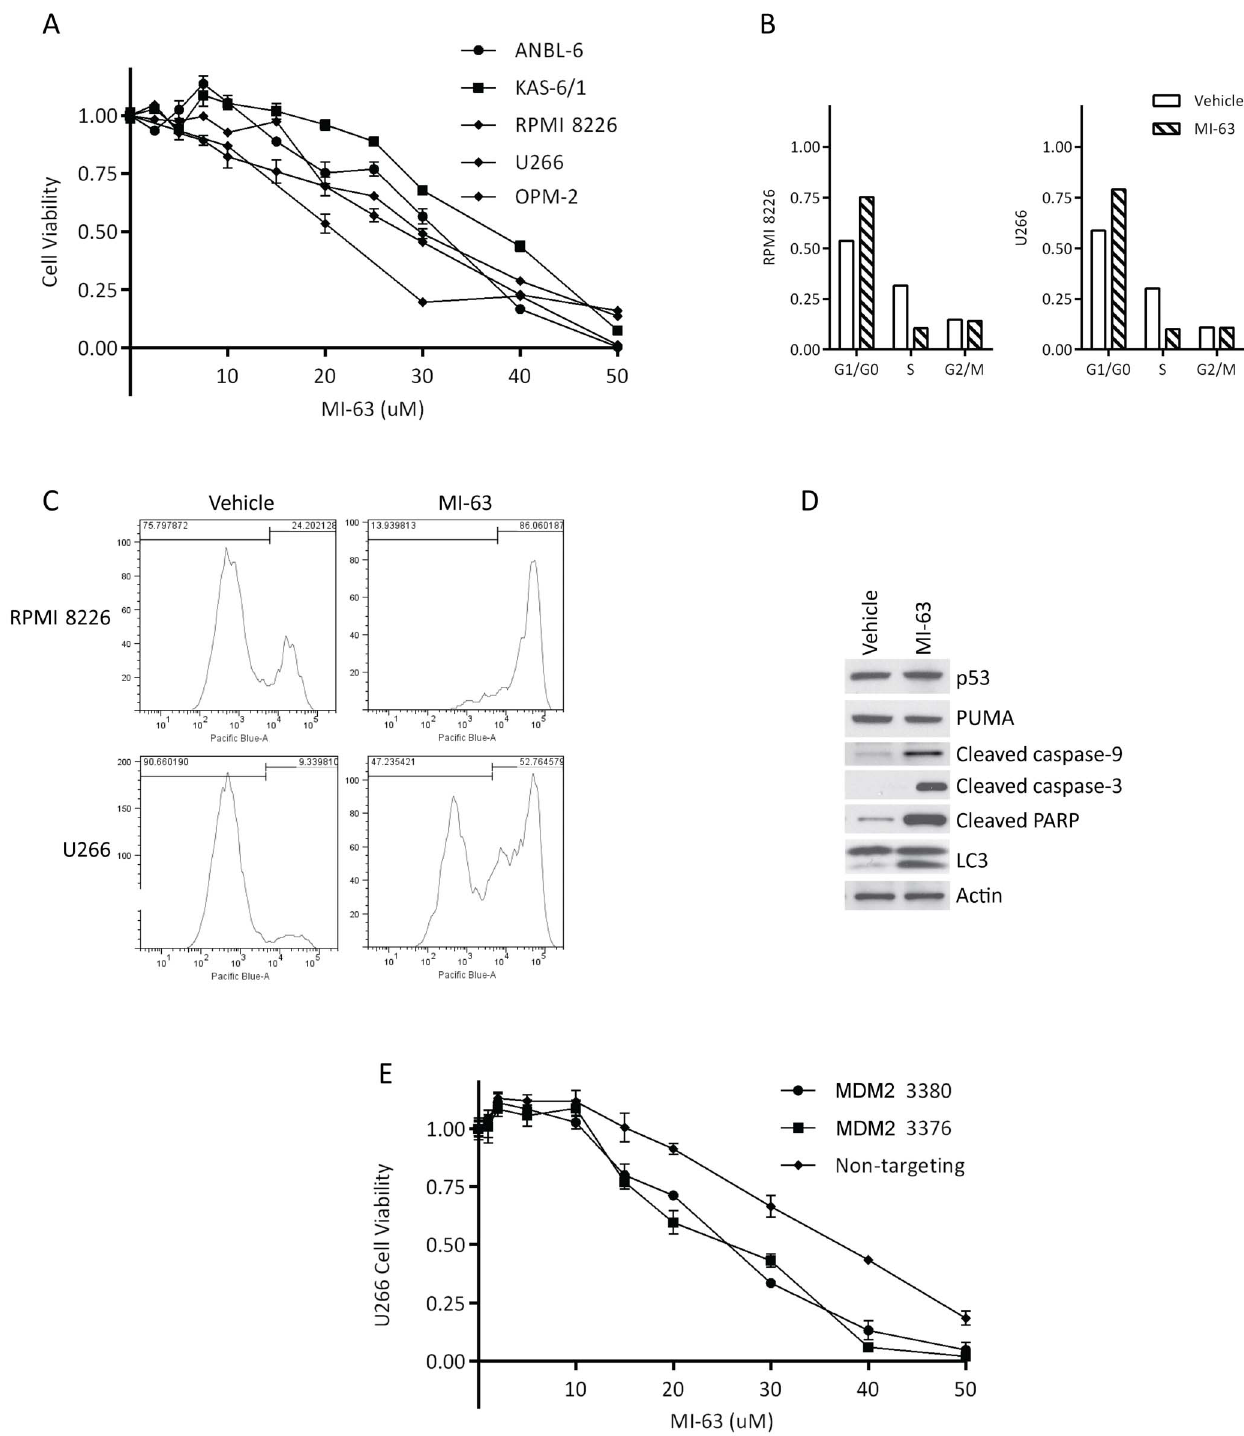
Figure 3. MI-63 is also active against mutant p53 myeloma cell lines. A. Cell viability assays were performed in a panel of mutant p53 myeloma cell lines, including ANBL-6, KAS-6/1, RPMI 8226, U266, and OPM-2 cells after exposure to MI-63 for 48 hours. B. Analysis of cell cycle distribution was performed in RPMI 8226 and U266 cells exposed to MI-63. C. Induction of apoptosis was evaluated by Annexin V staining and flow cytometry in RPMI 8226 and U266 cells treated with MI-63 at its IC 50 for 48 hours. D. Extracts of RPMI 8226 cells treated with MI-63 were subjected to Western blotting to detect key intermediates in apoptosis and autophagy. E. The impact of MDM2 suppression on the efficacy of MI-63 was studied in U266 cells harboring either a control shRNA, or one of two different constructs that suppressed expression of MDM2.